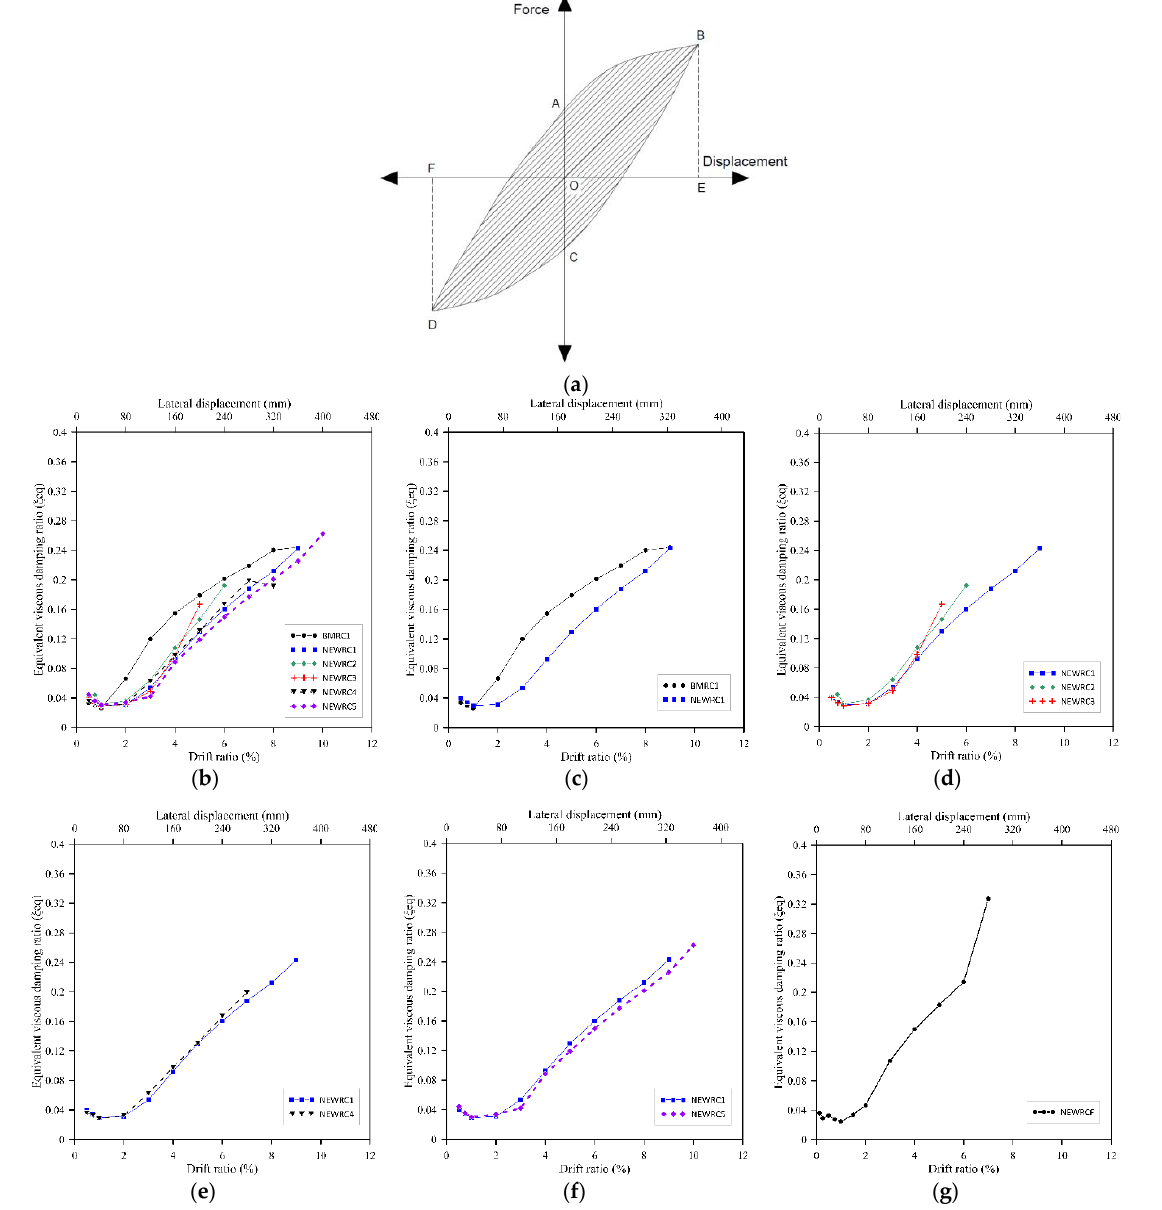
Figure 13. Equivalent viscous damping ratios of the specimens: ( a ) Hysteretic loop; ( b ) All column specimens; ( c ) BMRC1 and NEWRC1; ( d ) NEWRC1, 2 and 3; ( e ) NEWRC1 and 4; ( f ) NEWRC1 and 5; ( g ) NEWRCF.